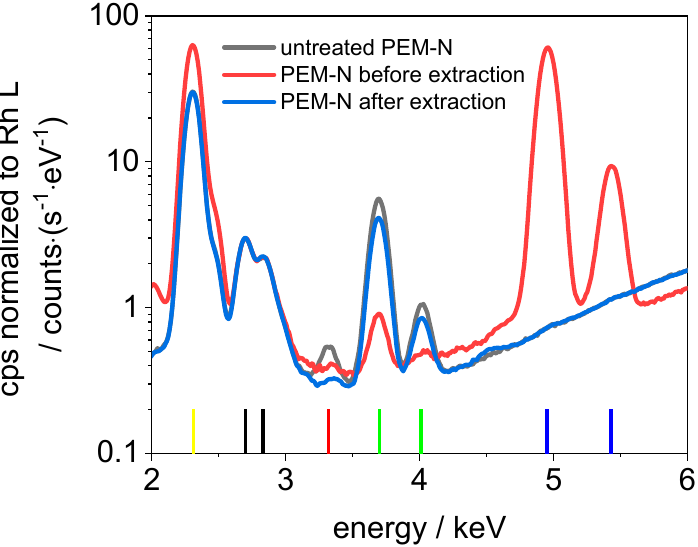
Figure 5. Sum spectra of untreated Nafion™, Nafion™ before and after extraction (normalized on Rh L). Vertical reference lines: yellow: S K α , black: Rh L α and L β , red: K K α , green: Ca K α and K β , and blue: V K α and K β .